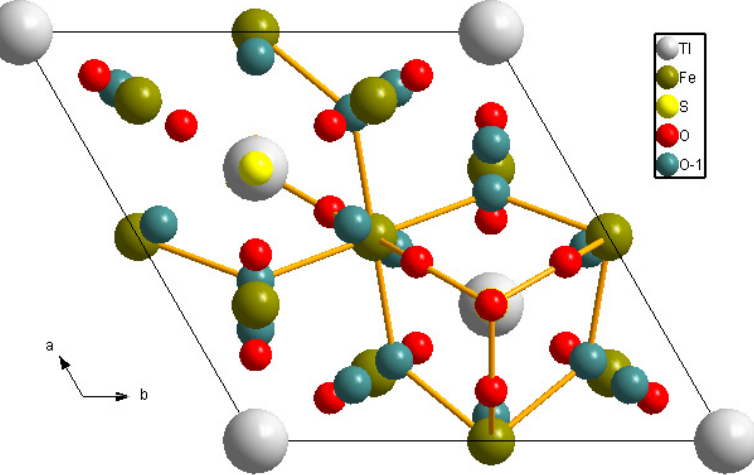
Figure 2. Crystal structure of dorallcharite.